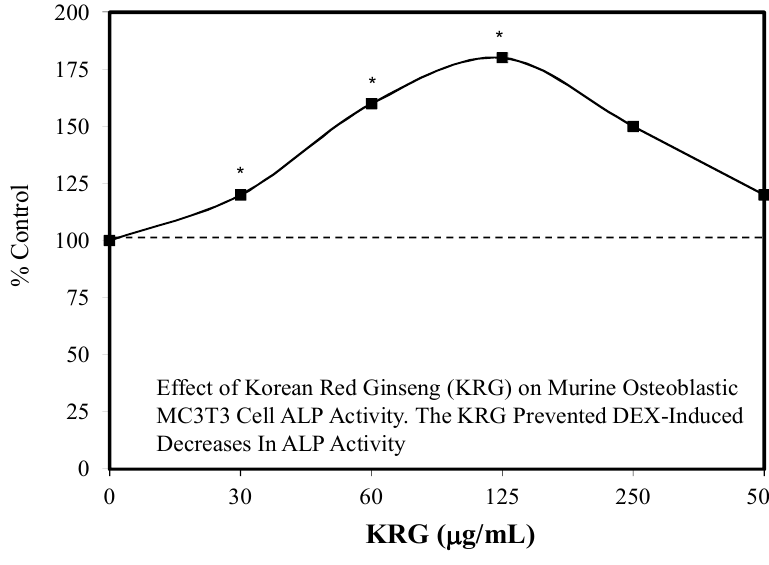
Figure 46. E ff ect of Korean Red Ginseng (KRG) on murine osteoblastic MC3T3 Cell ALP activity. The KRG prevented DEX-induced decreases in ALP activity (source: [131]). Each * represent statistical significance for a data